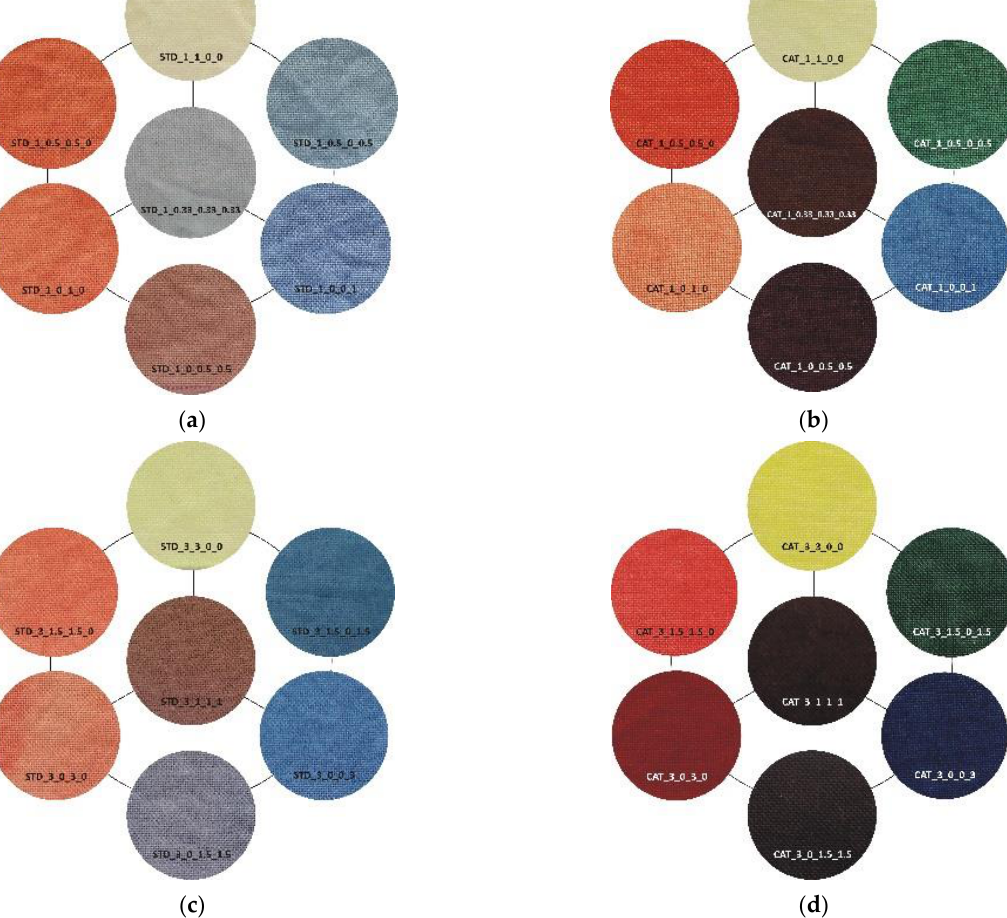
Figure 11. Visual representation of standard and cationized fabric dyed with vat dye: ( a ) Standard fabric — 1% owf dye, ( b ) cationized fabric — 1% owf dye, ( c ) standard fabric — 3% owf dye, ( d ) cationized fabric — 3% owf dye. To determine the color fastness to domestic and commercial laundering standard and cationized cotton fabric samples dyed with 3% owf vat dye were subjected to one washing